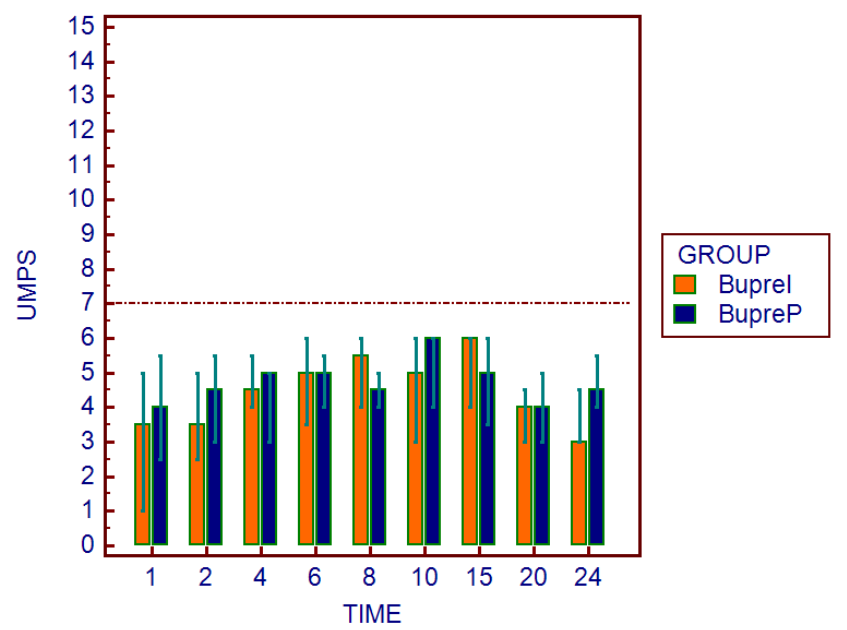
Figure 4. Graphical representation of the UMPS scores in the two study groups at different times (1, 2, 4, 6, 8, 10, 15, 20, and 24 h after the extubation). The dotted line indicates the maximum score level above which dogs required supplemental analgesia.